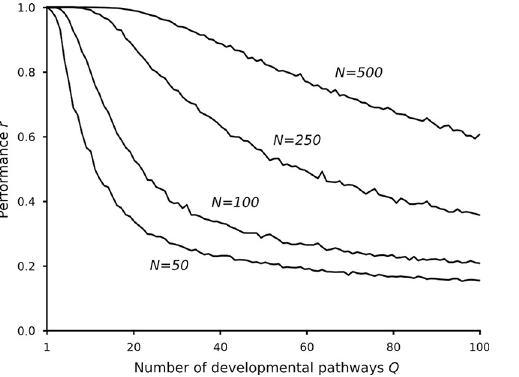
Fig 3. Performance of the analytic developmental networks with different number of genes and developmental pathways. Relevant parameters as in Fig 2 and σ = 0.1.